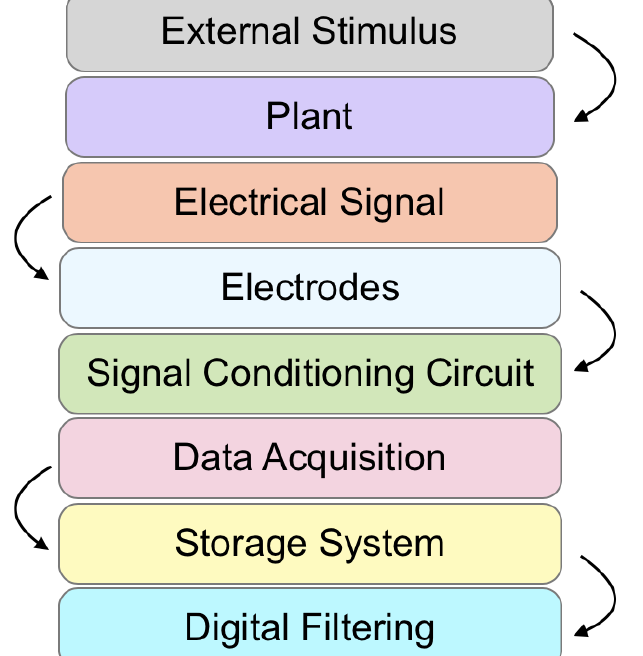
Figure 1. Flowchart of the steps used to acquire plants electrical signals. Adapted from [3,12]. Usually, when a sensor is used to measure a signal, the sensor reads not only the de- sired stimulus, but also noise. Furthermore, the measured electrical signal amplitude from the plant may not be large enough for proper data acquisition. Most signal conditioning circuits purpose is to filter, to reduce noise, and/or amplify the original signal in order to enable data